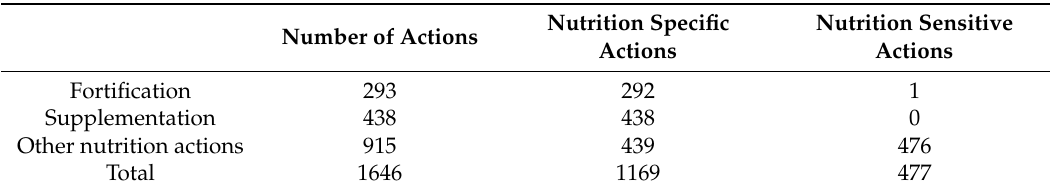
Table 3. Number of nutrition actions in the Global database on the Implementation of Nutrition Action (GINA) addressing micronutrient deficiencies, by type of action.